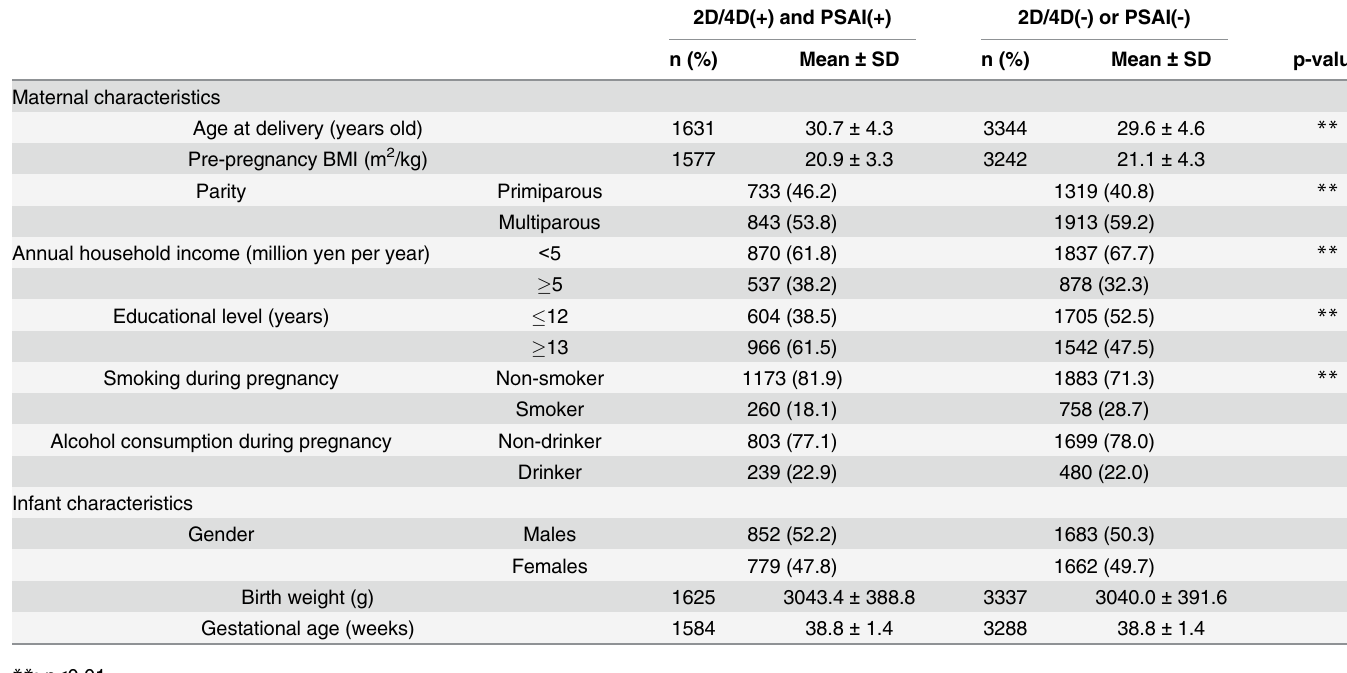
Table 2. Participant characteristics.